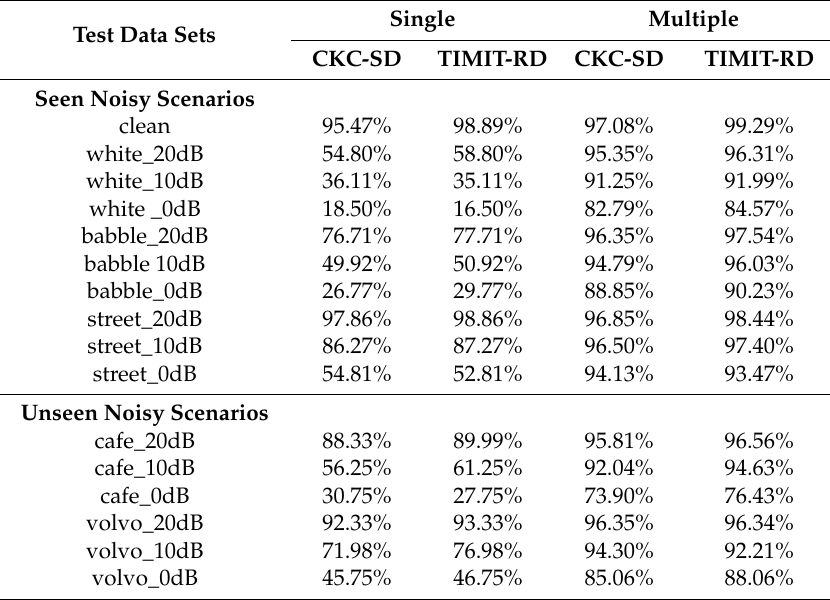
Table 5. Comparison of accuracy of single-scene and multi-scene training. Test Data